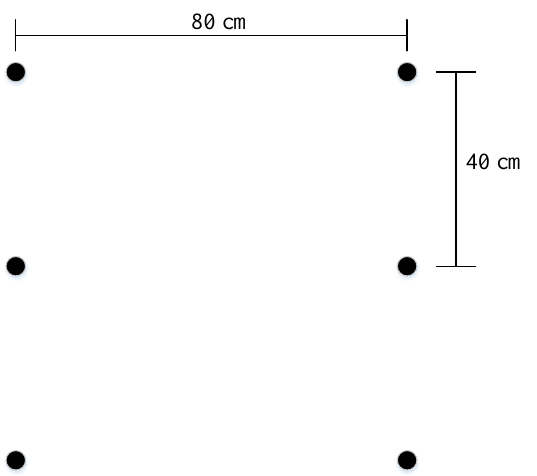
Figure 12. Blasting damage evolution law of groove-cavity in plane z = 0. ( a ) t = 0 µs. ( b ) t = 200 µs. ( c ) t = 400 µs. ( d ) t = 600 µs. ( e ) t = 800 µs. ( f ) t = 1000 µs.